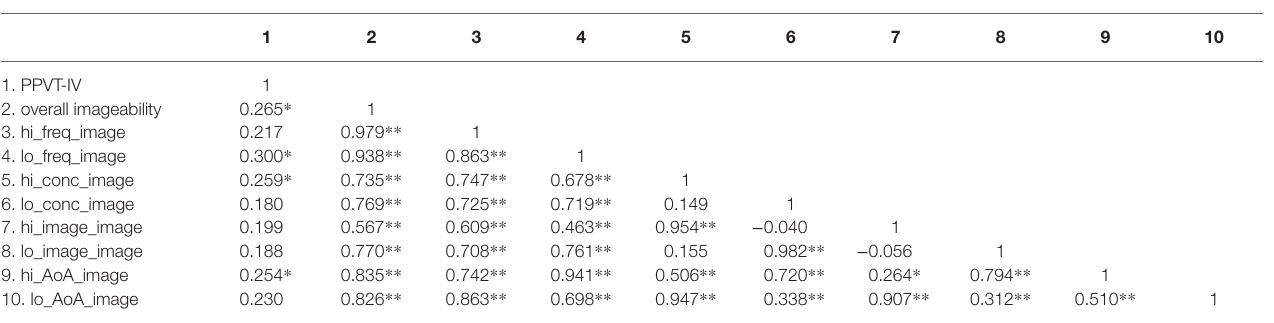
TABLE 4 | Correlation between PPVT-IV and main and subscores of imageability